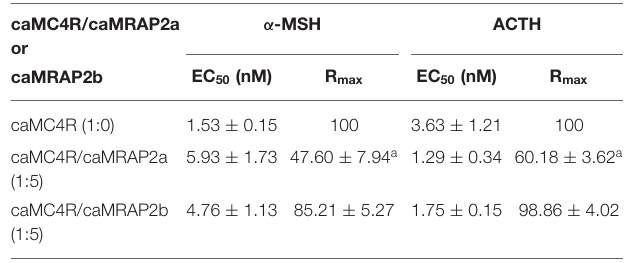
TABLE 4 | The effect of caMRAP2a or caMRAP2b on cAMP signaling properties of